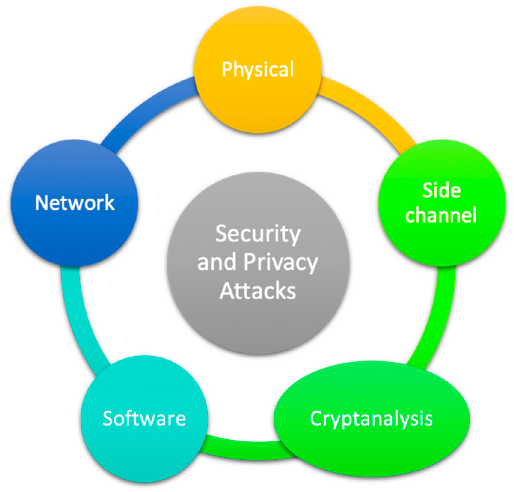
Figure 6. Security and privacy attacks.